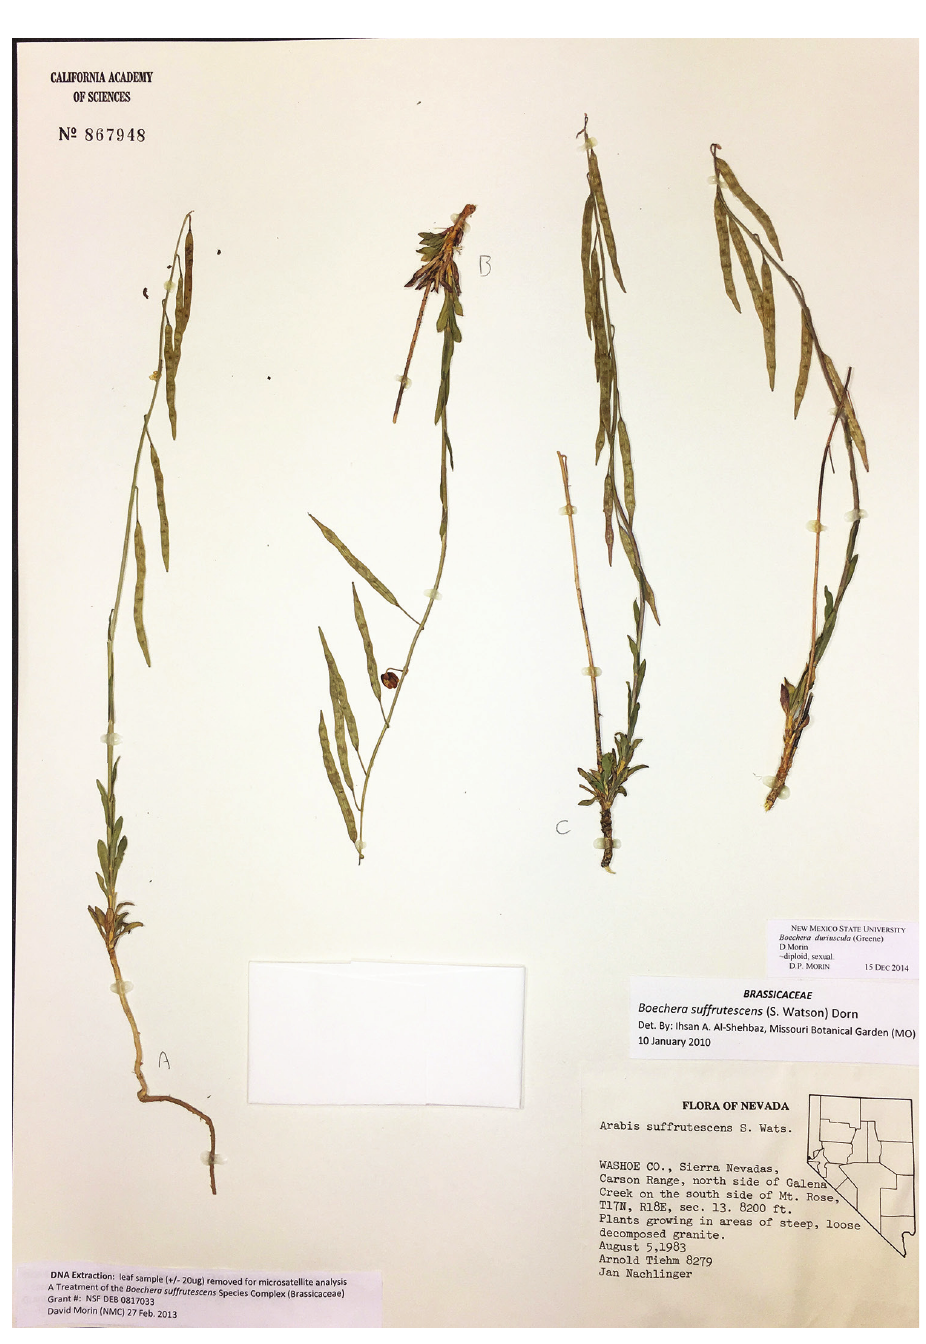
Figure 7. Boechera duriuscula , Tiehm and Nachlinger 8279